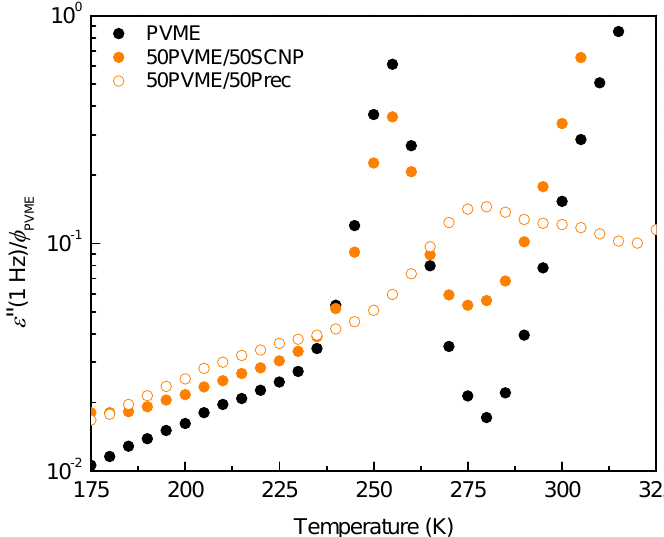
Figure 1. Isochronal ε (cid:48)(cid:48) ( T ) , obtained at 1 Hz on pure poly(vinyl methyl ether) (PVME) (black symbols), the 50% mixtures with the single-chain polymer nanoparticles (SCNPs) (full symbols), and with the precursor (empty symbols). For each sample, the ε (cid:48)(cid:48) values are divided by the PVME weight fraction φ PVME .